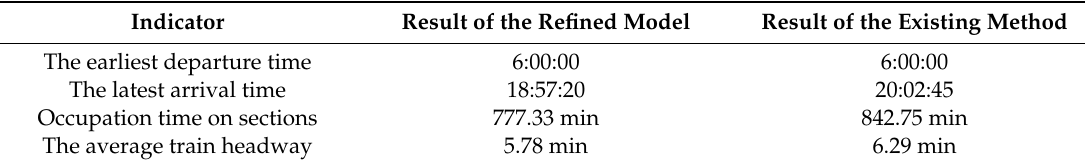
Table 8. Comparison of the relevant indicators.